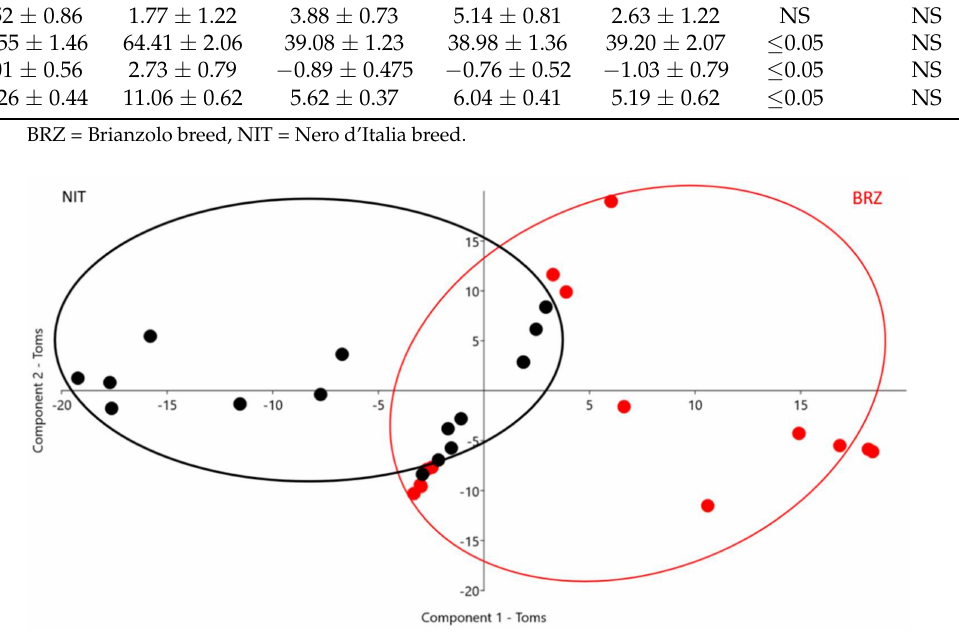
Figure 1. Scatter plot principal component analysis (PCA) for morphometric parameters and in- dexes in toms. Every spot represents a bird and every color a breed (BRZ = red: Brianzolo breed, NIT = black: Nero d’Italia breed; ellipses are a visual grouping sign).